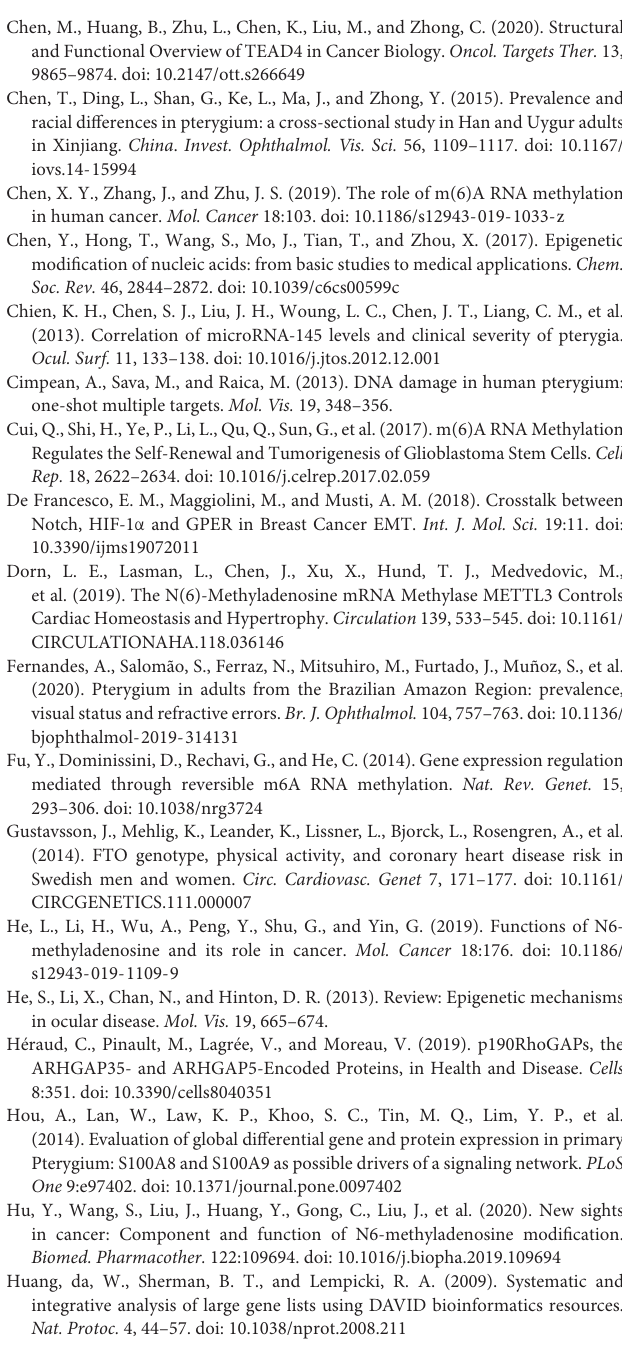
Supplementary Table 1 | The detail of clinical information about 24 pterygium patients. Supplementary Table 2 | List of primers used for qRT-PCR. Supplementary Table 3 | Most relevant networks of lncRNA and hyper- or hypo-methylated peaks. Supplementary Table 4 | Most relevant networks of lncRNA from RNA-seq. Supplementary Table 5 | Most relevant networks of m6A-modified